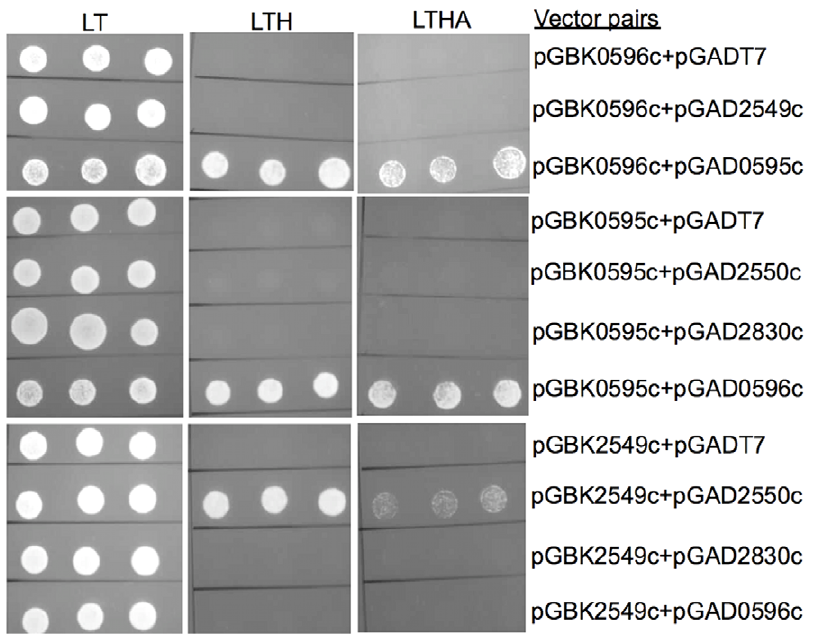
Figure 6. Y2H analysis of VapC-VapB interactions. Interactions between VapCs and either cognate or non-cognate VapBs were tested by co- transformation and scoring for growth on selection (LT) vs . media of differing stringency. Three independent colonies of each strain were re- suspended in sterile water, the cell density adjusted to an OD 600 of 1 and aliquots spotted on plates. LT, Leu-Trp; LTH, Leu-Trp-His; LTHA, Leu-Trp-His- Ade dropout-supplemented